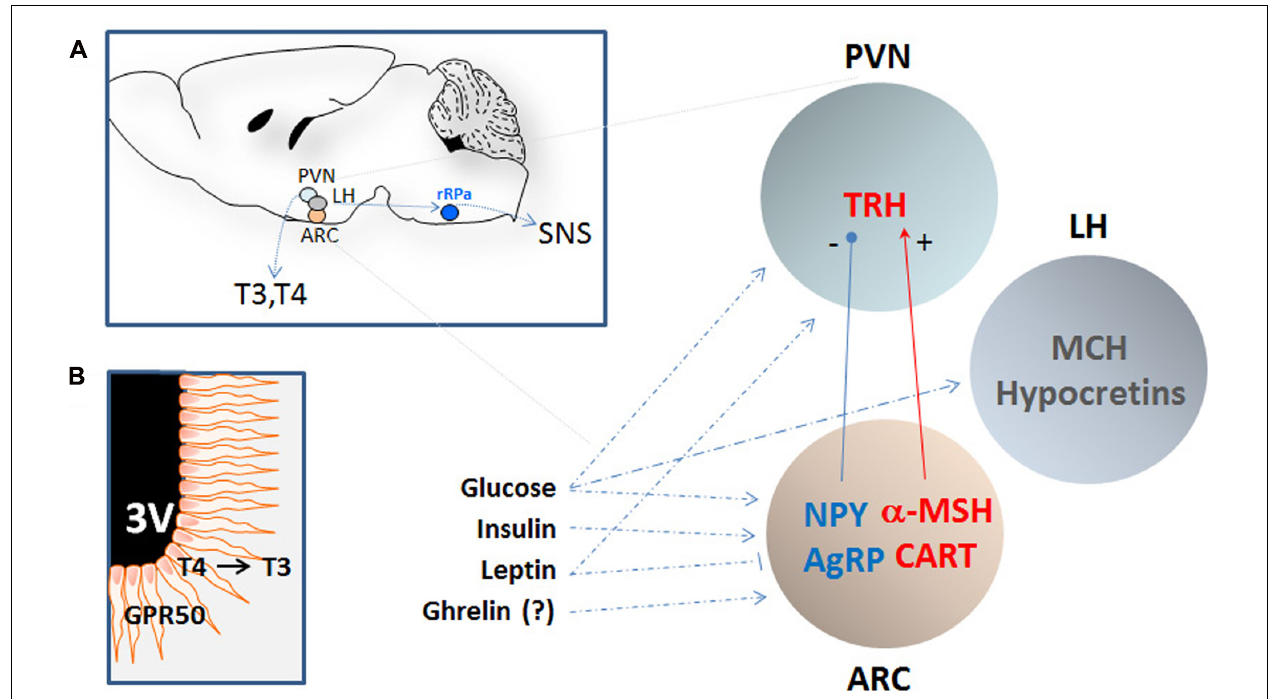
FIGURE 1 | Schematic representation of the hypothalamic nuclei and the neuropeptides that regulates calorie intake and energy expenditure by affecting core body temperature. (A) The approximate location of the periventricular nucleus (PVN), the arcuate nucleus (ARC), and the lateral hypothalamus (LH) are shown in a sagittal section of the mouse brain (left). These regions are in polysynaptic contact with the BAT (not shown) via the raphe pallidus (RPa) and can regulate CBT by affecting the sympathetic nervous system (SNS). In addition, CBT can also be affected by thyrotropin-releasing hormones (TRH) that determines the levels of circulating thyroid hormonesT3 andT4.The PVN and the ARC contain neurons that can respond to nutritional state by modulating the level of specific orexigenic or anorexigenic neuropeptides.The orexigenic neuropeptideY (NPY) and agouti-related protein (AgRP) are elevated during calorie restriction or food deprivation and are strong stimulator of appetite and reduce CBT by acting on the SNS as well as by reducing the level ofTRH in the PVN. In contrast, the anorexigenic peptide α -melanocyte-stimulating hormone ( α -MSH), and